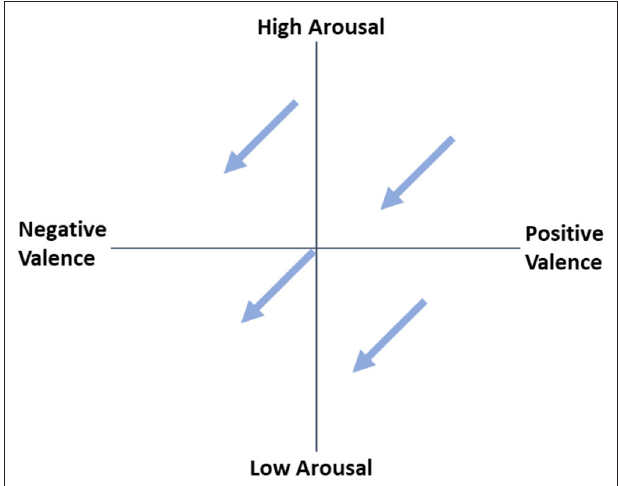
FIGURE 2 | Adaptation direction for a negative relationship between both valence and arousal and performance with different